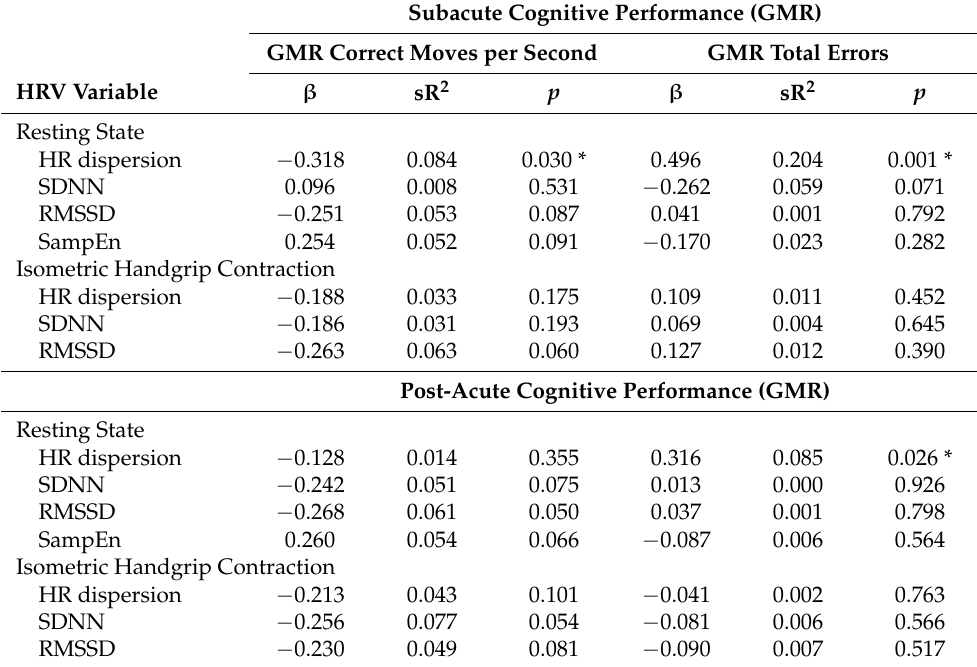
Table 8. Multivariate regression analyses for Groton Maze Recall (GMR) a .